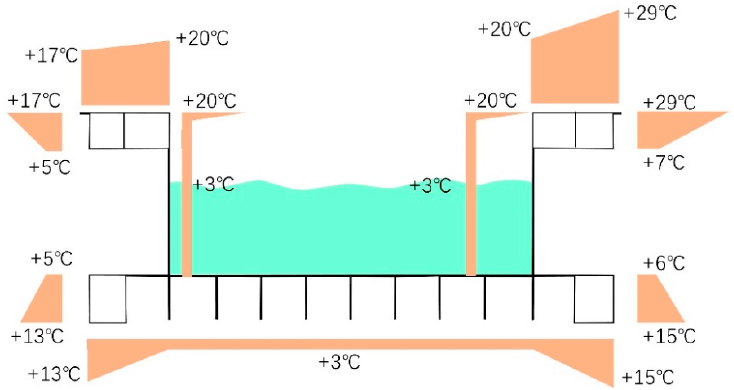
Figure 14. Fitted curves of temperature gradients of the surfaces B and C in summer. For engineering application, a simplified critical temperature gradient in summer with a regular water level (5.05 m) is provided in Figure 15. This temperature gradient is also obtained at 2 p.m. when the ambient air temperature is 30 °C. The temperature gradient is the increment over the ambient air temperature.